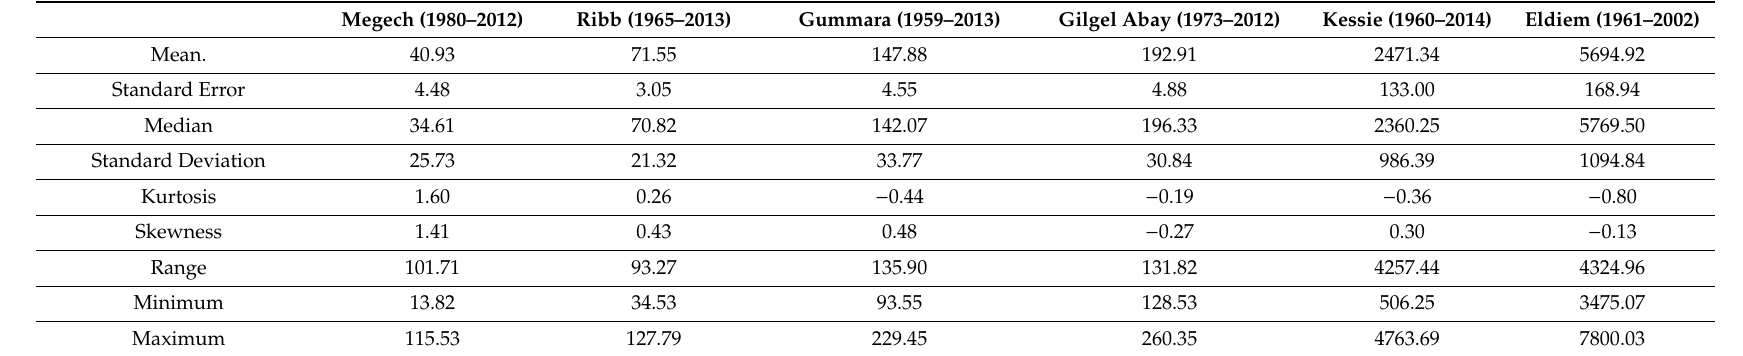
Table 1. The main statistical characteristics of the annual maximum flow data in the six selected gauging